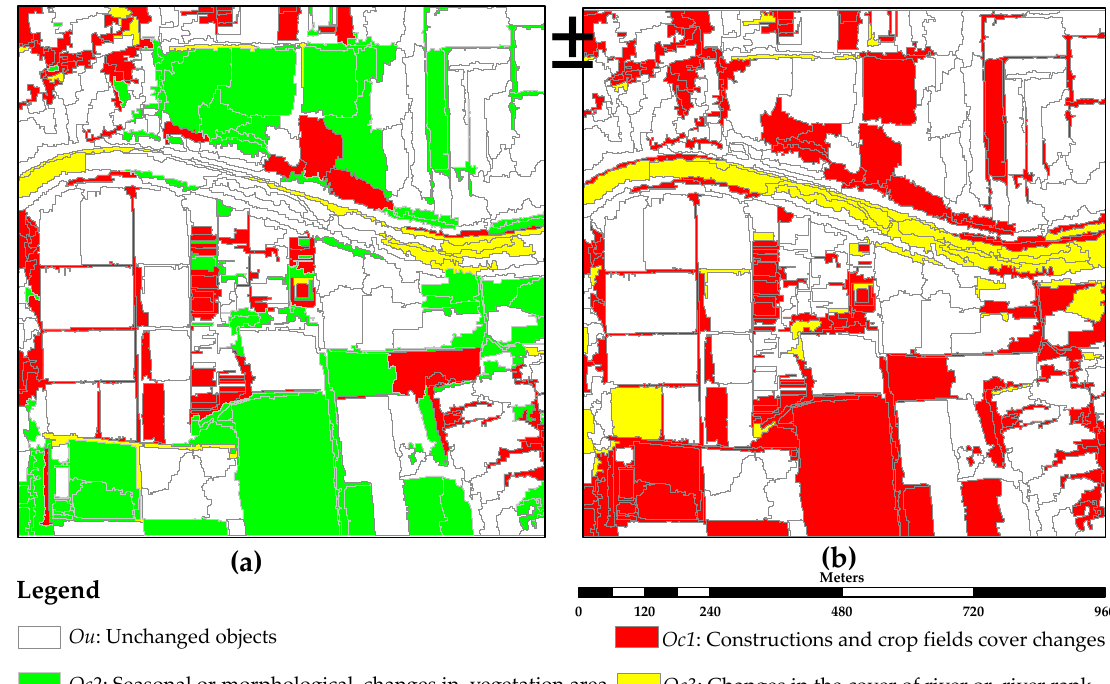
Figure 6. The OBCD result map obtained with ( a ) the proposed SAW-CVA approach and ( b ) the standard CVA approach.